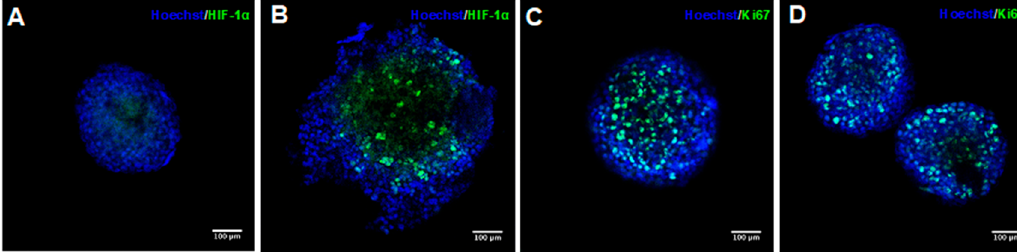
Figure 3. Fluorescence confocal microscopy images of PDX tumor spheroids BL0293 ( A,C ) and BL0808 ( B,D ). Cell nuclei stained in blue, hypoxic inducible factor 1 α (HIF-1 α ) and Ki67 protein stained in green; 20× magnification, scale bar = 100 μ m.